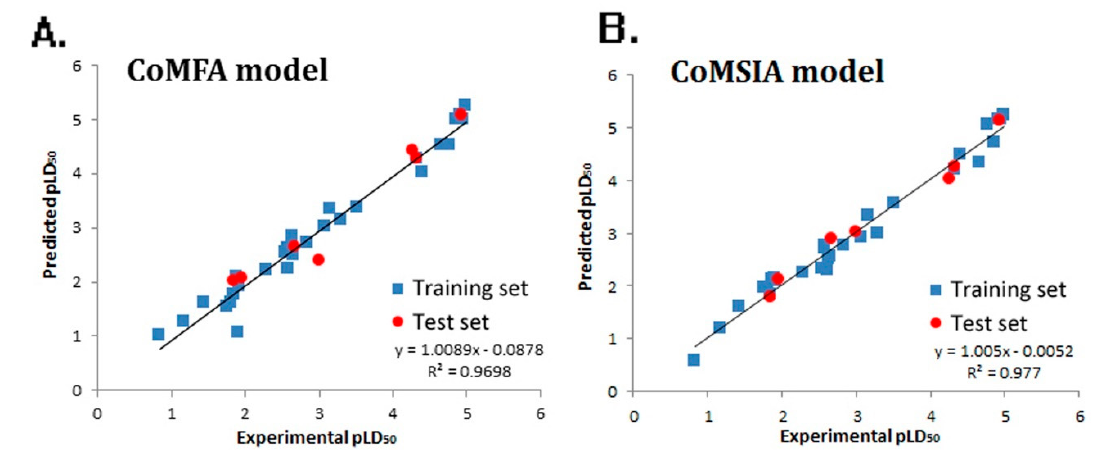
Figure 2. Experimental versus predicted activity of the training and test sets based on the comparative molecular field analysis (CoMFA) model ( A ) and comparative molecular similarity index analysis (CoMSIA) model ( B ).